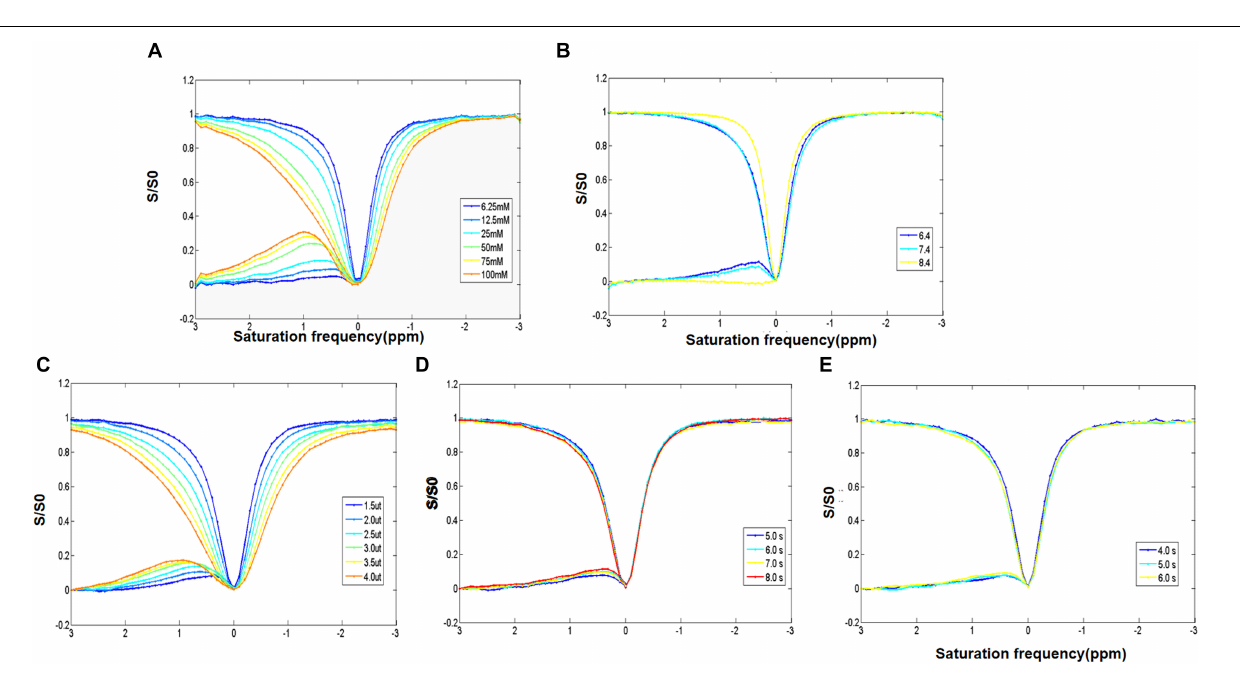
FIGURE 2 | (A) Z-spectrum and MTR of different concentrations of D-glucose showing the direct saturation exchange rate of D-glucose and that water protons increase with the increase of D-glucose concentration. (B) Z-spectrum and MTR of D-glucose with different PH values examining the impact of pH. It indicates that the D-glucose effect is negatively correlated with pH. (C–E) Z-spectrum and MTR investigating the optimization of the saturation energy and echo and saturation time parameters. The D-glucose CEST effect increases with the increase in saturation energy and saturation and echo